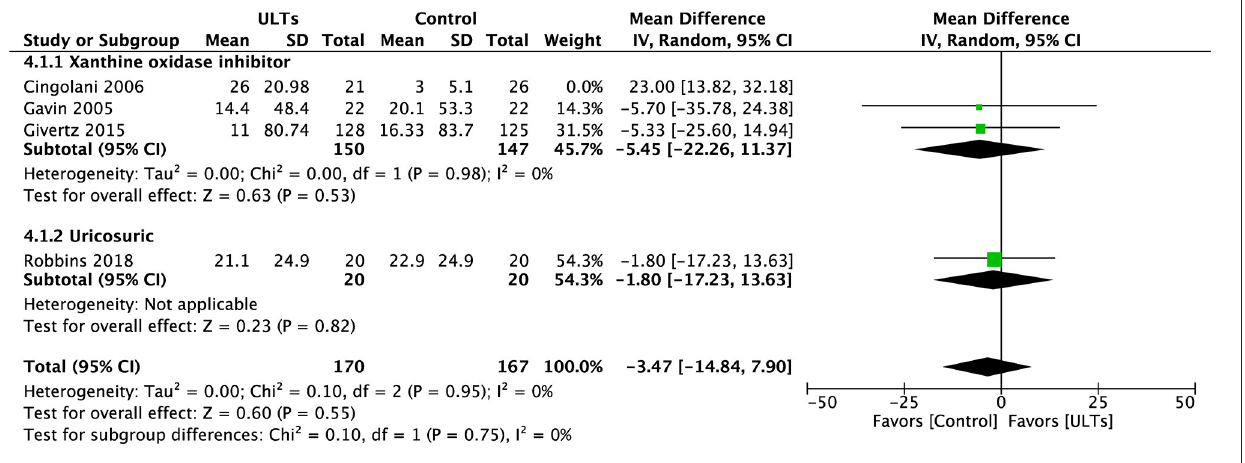
FIGURE 8 | Meta-analysis of 6-Min Walk Test without Cingolani et